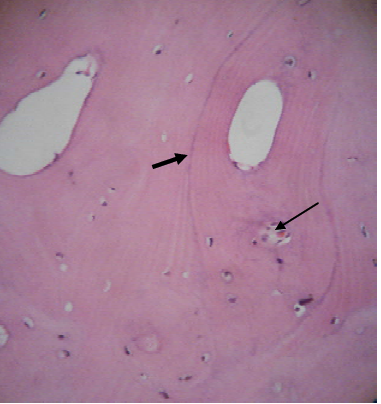
Figure 2. Histology of the bone biopsy shows mature thick cortical lamellar bone with regular prominent cement lines (thick arrow) with prominent osteoblasts (thin arrow) within the harvesian